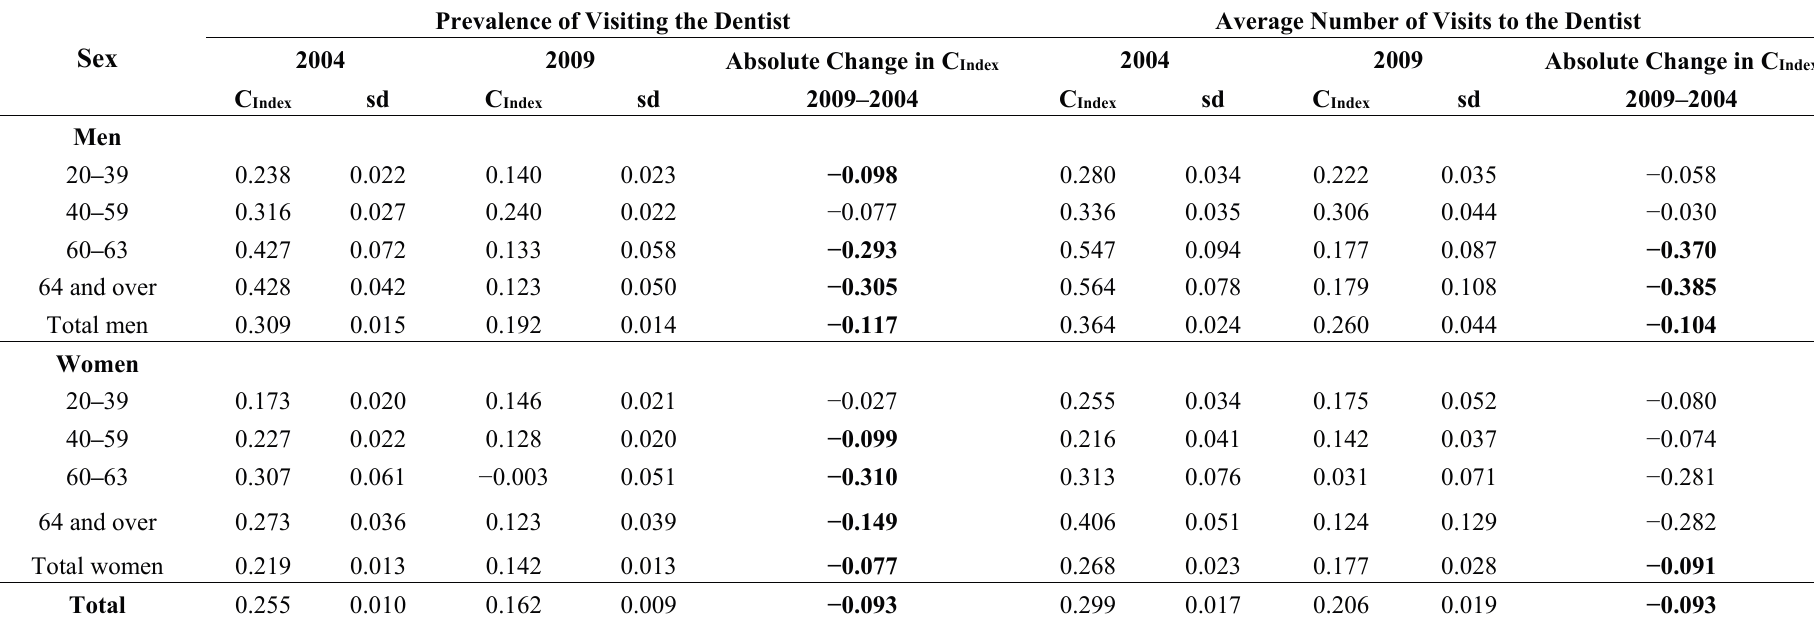
Table 4. Socioeconomic inequalities in dental care utilization and their absolute changes among population aged 20 and over. “Social Protection Survey”, Chile 2004 and